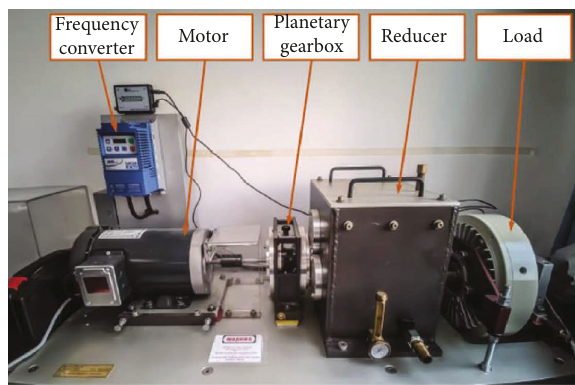
Figure 12: Planetary gearbox experimental bench.